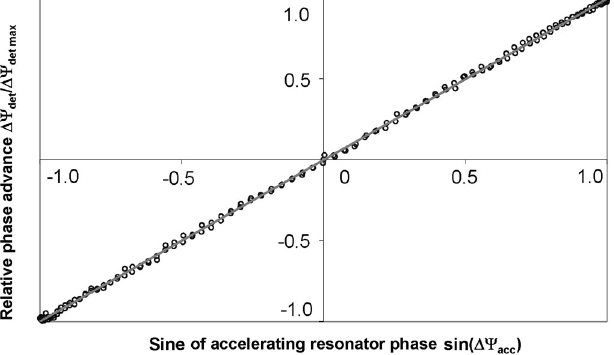
FIG. 7. Example of SLR rf field, generated by a bunched beam passing through the resonator. The energy of the 58 Ni þ 22 beam is 185 MeV and the beam current is 7 nA. The last (12th) linac resonator is used as the phase detector.